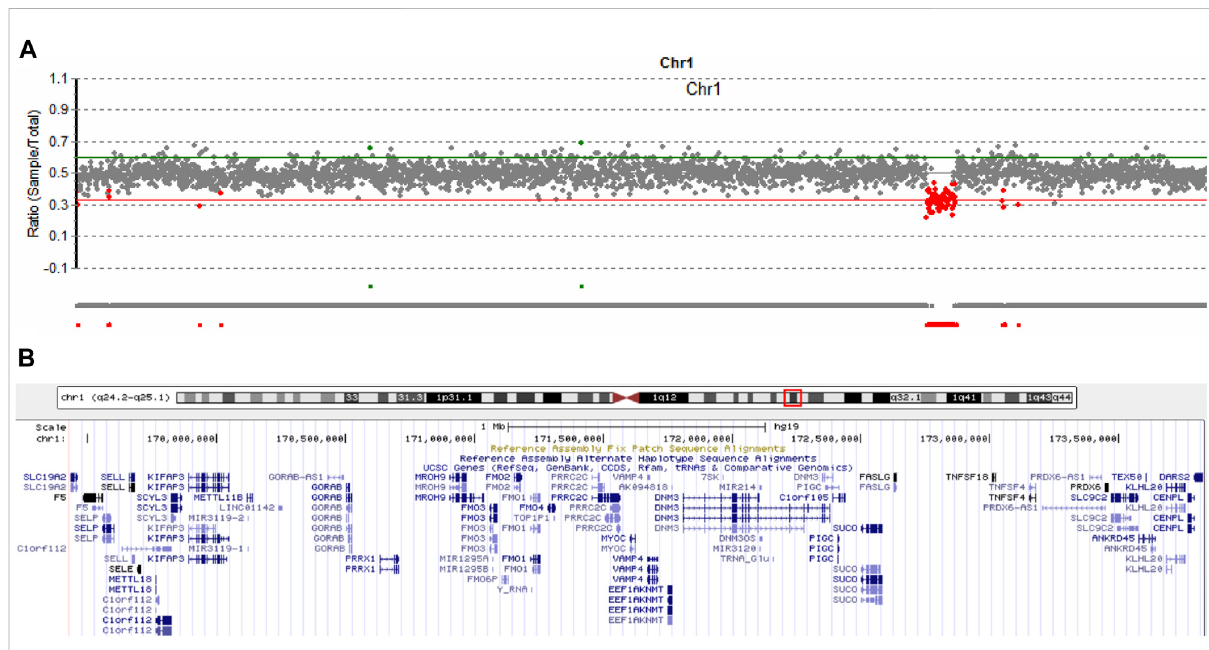
FIGURE 4 Copynumbervariation analysisinpatient1. (A) Sequencing depthanalysis usingtheWESdatashowedpatient1harbored1q24.2-q25.1deletion (hg19, chr1:169,433,149-173,827,682). (B) Involving genes in the 1q24.2-q25.1